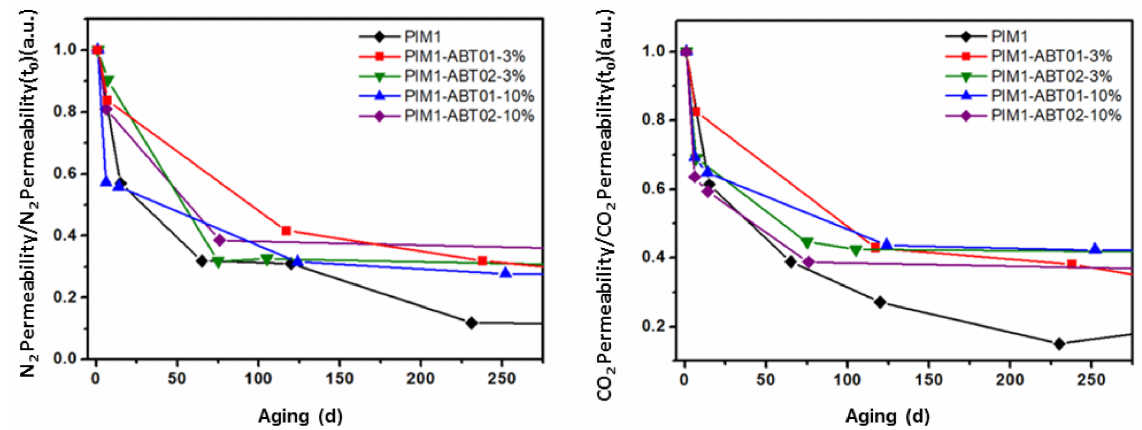
Figure 9. Normalized permeability data with respect to t 0 values of PIM-1 ( (cid:7) ), PIM1-ABT01-3% ( (cid:4) ), PIM1-ABT01-10% ( (cid:78) ), PIM1-ABT02-3% ( (cid:72) ), PIM1-ABT02-10% ( (cid:7) ), as function of time over 1 year. Lines are drawn to guide eye.